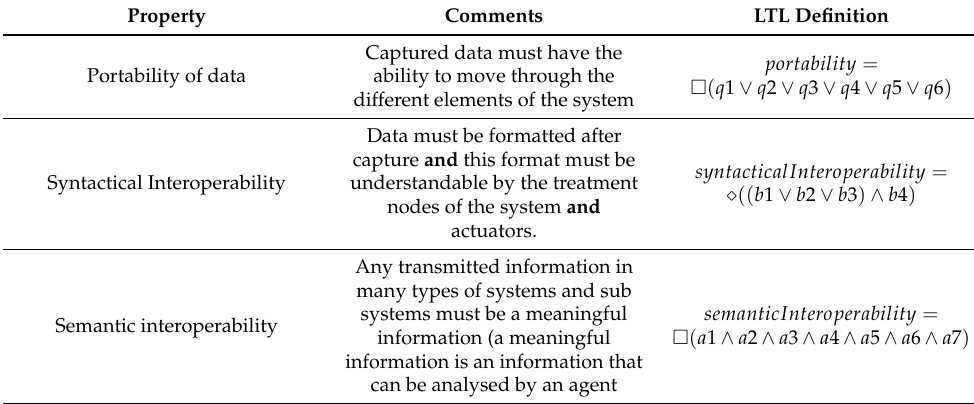
Table 9. Some LIS